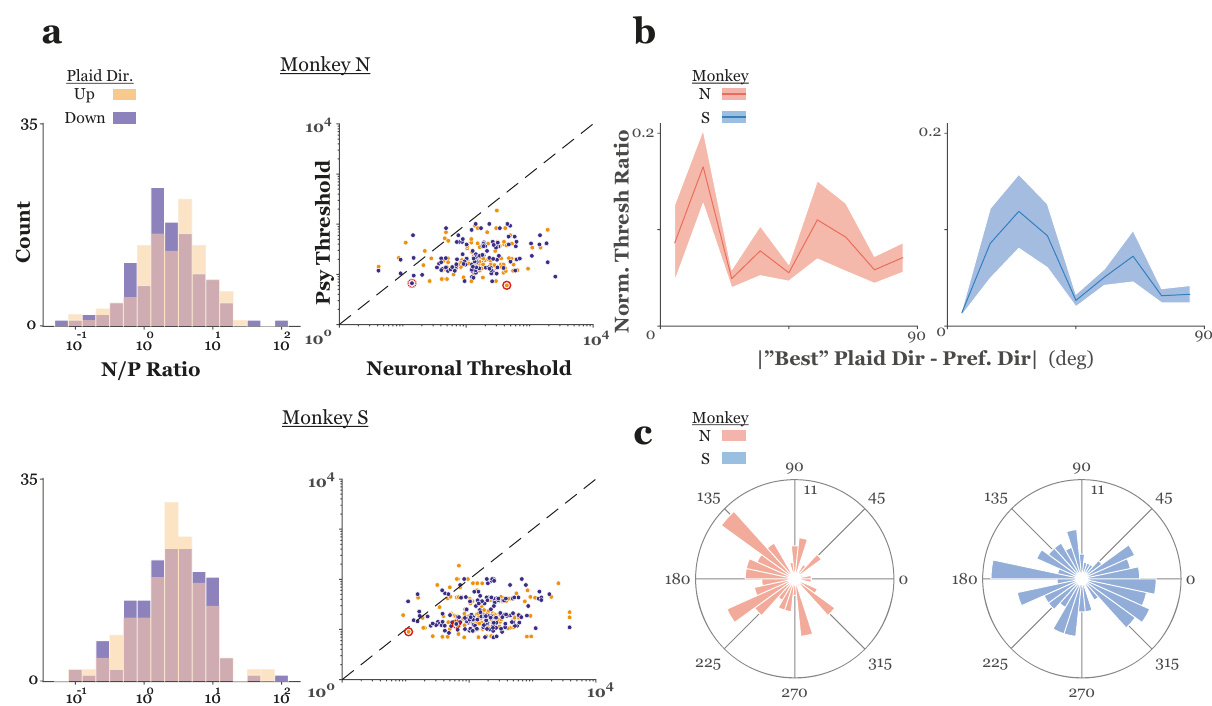
Fig. 5 | Neuronal sensitivity to plaid segmentation cues. a The left panels show the distribution of the N/P ratio (neuronal/psychophysical threshold); each cell contributes two data points, one for each direction of pattern motion. In the right panels, psychophysical threshold (ordinate) is plotted versus neuronal threshold (abscissa)forallunitsinthesample.Datainthetop(bottom)rowisfrommonkeyN (S). b The normalized threshold ratio is plotted against the magnitude of the dif- ferencebetweenthebestplaiddirectionandaunit ’ spreferreddirection.The “ best ”